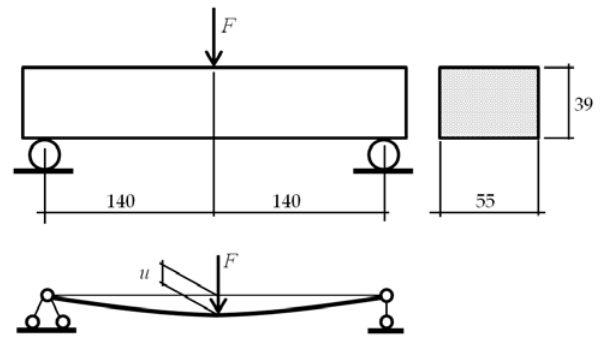
Figure 4. Beam schema. The dimensions are given in mm.